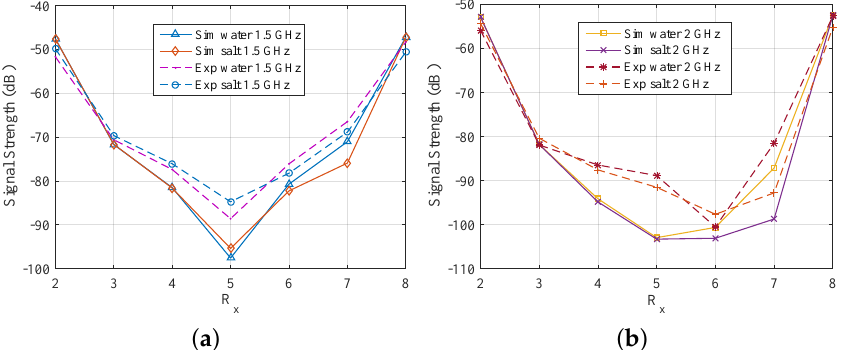
Figure 11. Comparison of received signal strength as a function of receiver number from simulations and measurements when the array is immersed in 90% glycerine–water, and targets are introduced. Plots at ( a ) at 1.5 GHz and ( b ) at 2